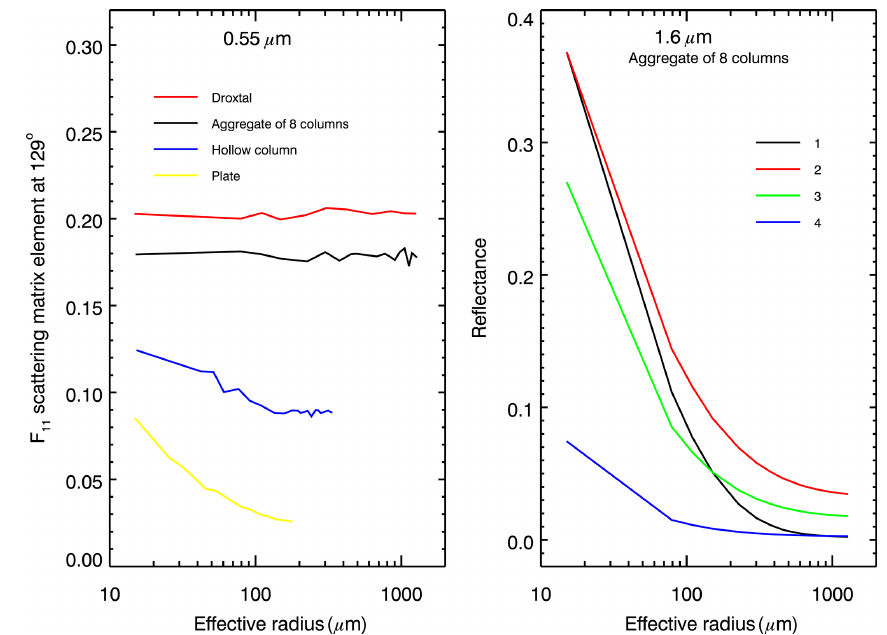
Figure 3. Left panel: phase function at 0.55µm for scattering angle of 129 ◦ , extracted from the original database (Yang et al., 2013) as a function of effective radius. Right panel: reflectance of snow layer at 1.6µm consisting of aggregates of 8 columns, calculated assuming that (1) phase function depends on the effective radius (black line), (2) phase function is constant corresponding to the effective radius of 15µm (red line), (3) same as (2) but for effective radius of 150µm (green line) and (4) same as (2) but for effective radius of 1150µm (blue